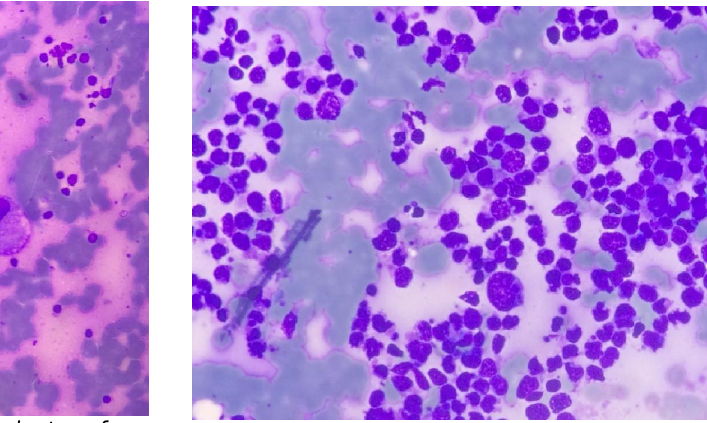
Fig 6: Smear showing malignant clusters of small cell